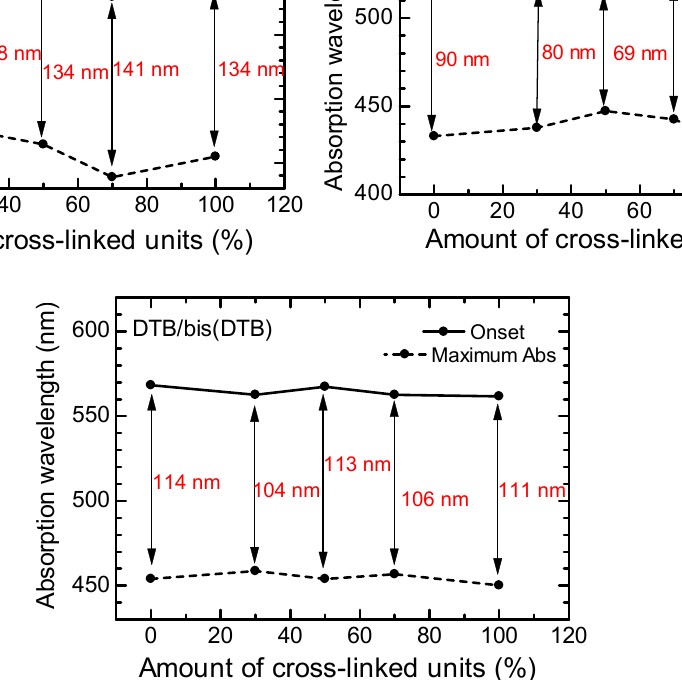
Figure 7. Maximum absorption wavelength and onset wavelength of polymer films synthesized from the BT/d(BT) group, DTC/bis(DTC) group, and DTB/bis(DTB) group with different RCUs. The differences between the maximum absorption wavelength and the onset wavelength are annotated in red letters.